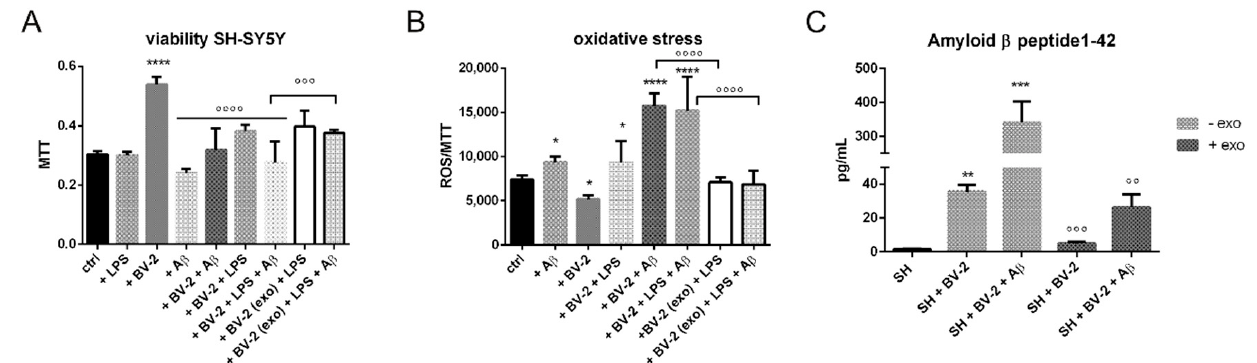
Figure 6. The effect of hAFSC-exo on transwell co-culture SH-SY5Y BV-2. ( A ) Graph of MTT assay of neuron cells exposed to (+/- LPS) BV-2 and/or A β in presence or absence of exo. * p = 0.048; ****, ◦◦◦◦ p -values < 0.0001. ( B ) Graph of ROS content (normalized to MTT) in neuron cells exposed to (+/- LPS) BV-2 and/or A β in presence or absence of exo. A β * p = 0.049; BV-2 * p = 0.042; BV-2 + LPS * p = 0.040; ****, ◦◦◦◦ p -values < 0.0001. ( C ) ELISA test of A β concentration in conditioned medium obtained from the co-culture of neurons and microglia cells treated as previously reported. ** p = 0.001; ◦◦ p = 0.002; *** p = 0.0002; ◦◦◦ p = 0.0003.